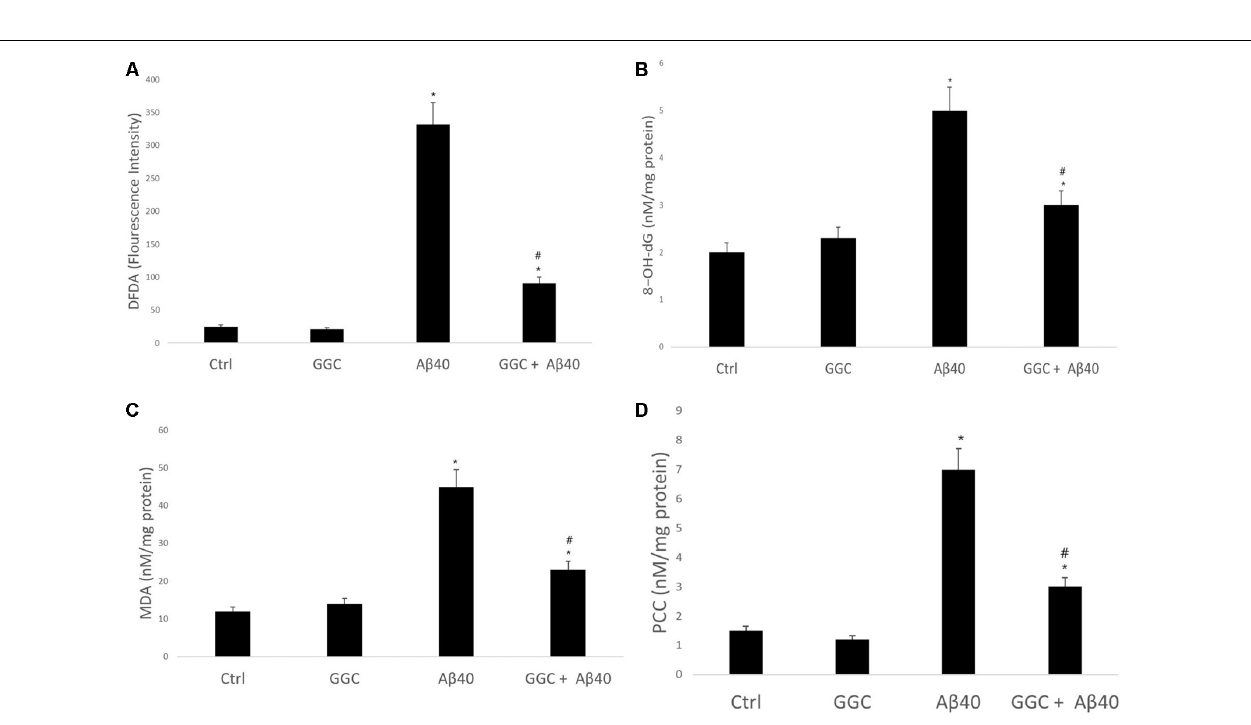
FIGURE 2 | GGC attenuates oligomeric A β 40 -mediated oxidative stress production and oxidative damage to DNA, lipids, and protein in isolated adult astrocytes. (A) Oligomeric A β 40 increased reactive oxygen species production using the DCFDA Assay, and which was reduced by treatment with GGC. Co-treatment with GGC also ameliorated (B) oxidative DNA damage, (C) lipid peroxidation, and (D) protein carbonyl formation. Significance ∗ p < 0.05 compared to control non-treated cells. # p < <0.05 compared to control cells treated with oligomeric A β 40